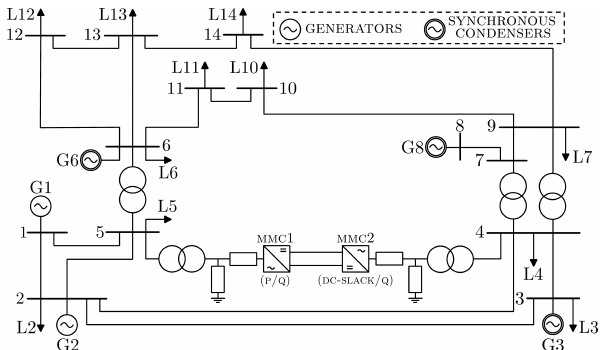
Figure 6. The schematic of the modified IEEE 14 power system. Compared to its counterpart in Figure 2, the line between bus 4 and 5 has been substituted with an HVDC link made up of two MMC